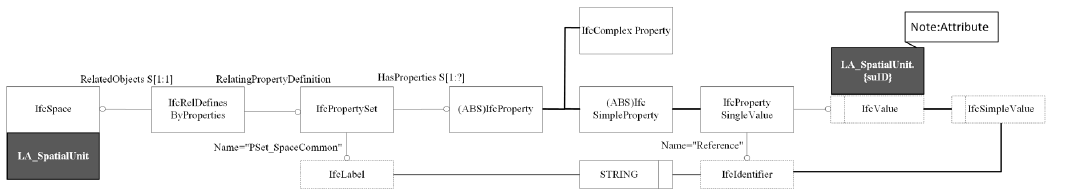
Figure 6. Mapping between the LADM and the IFC: Properties.